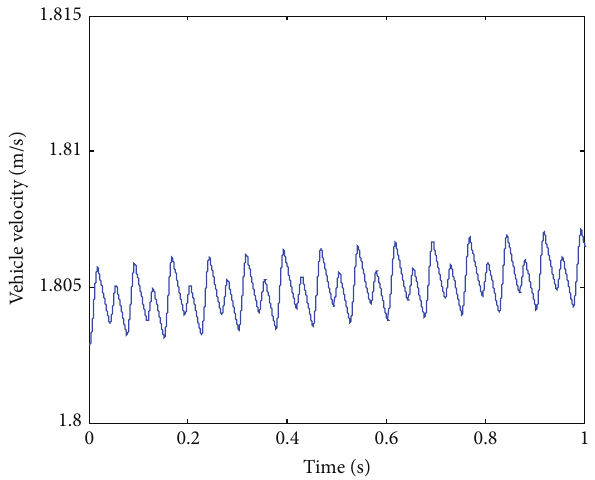
Figure 22: The vehicle velocity on the creeping condition.